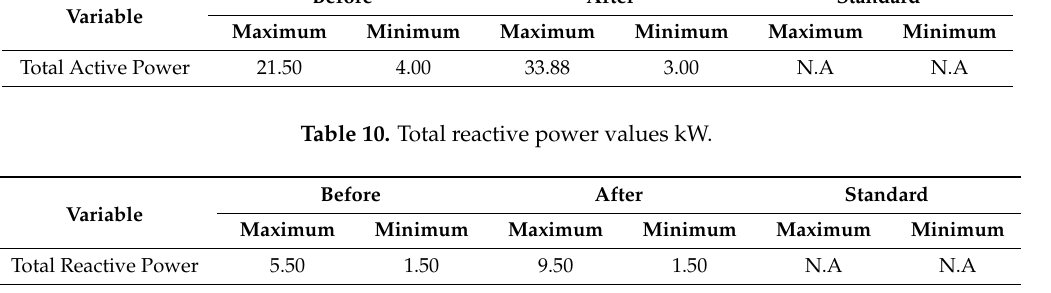
Table 9. Total active power values kW.